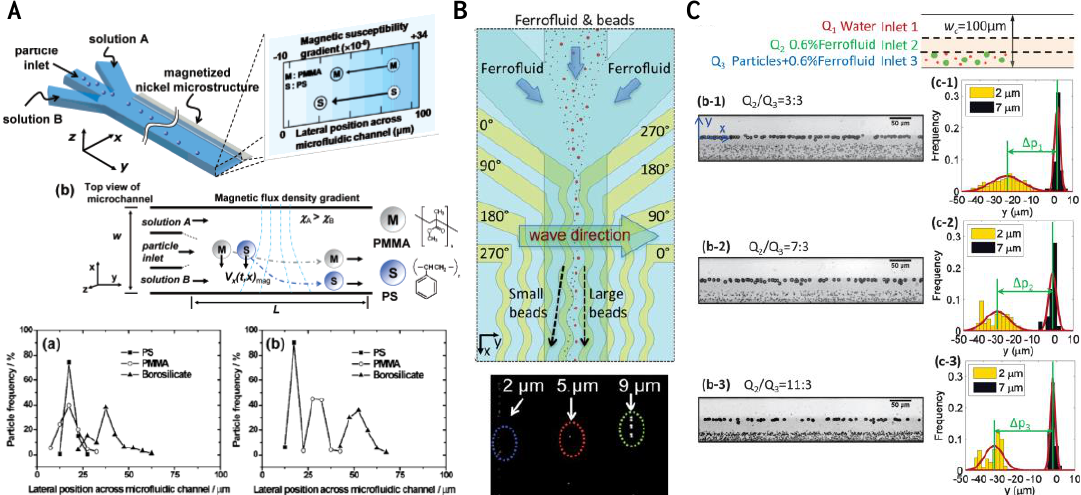
Figure 11. Diamagnetic particle separation in the flow of magnetic fluids with two-sheath-flow focusing. ( A ) Schematic of isomagnetophoresis (top) and measured positions of similar-sized PS, PMMA, and borosilicate (BS) spherical beads (approximately 15 µ m in diameter) in conventional magnetophoresis and isomagnetophoresis (bottom). Adapted with permission from Kang et al. [137], © 2007 American Chemical Society. ( B ) Schematic of the separation channel of the ferrofluid-mediated nanocytometry chip (top) and fluorescence microscope snapshot of the separated 2.2, 4.8, and 9.9 µ m PS beads in EMG 700 ferrofluid at the channel outlet. Adapted with permission from Kose and Koser [138], © 2012 American Chemical Society. ( C ) Configuration for inlet solutions of the microchannel (top) and the stack images / Gaussian distributions of 2 µ m and 7 µ m PS beads at the channel outlet.